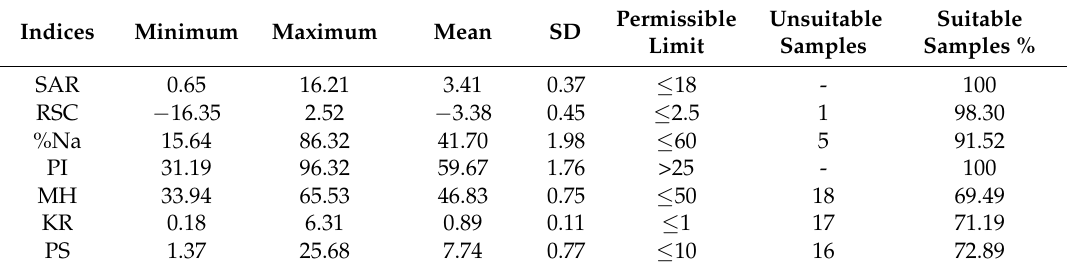
Table 6. Statistical summary of irrigation quality indices of groundwater samples.